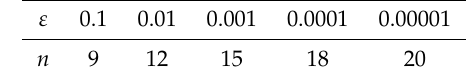
Table 17. Number n of iterations needed by the a posteriori estimate if started with x = ( 19.27,19.27 ) , y = ( 19.36,19.36 ) and p =